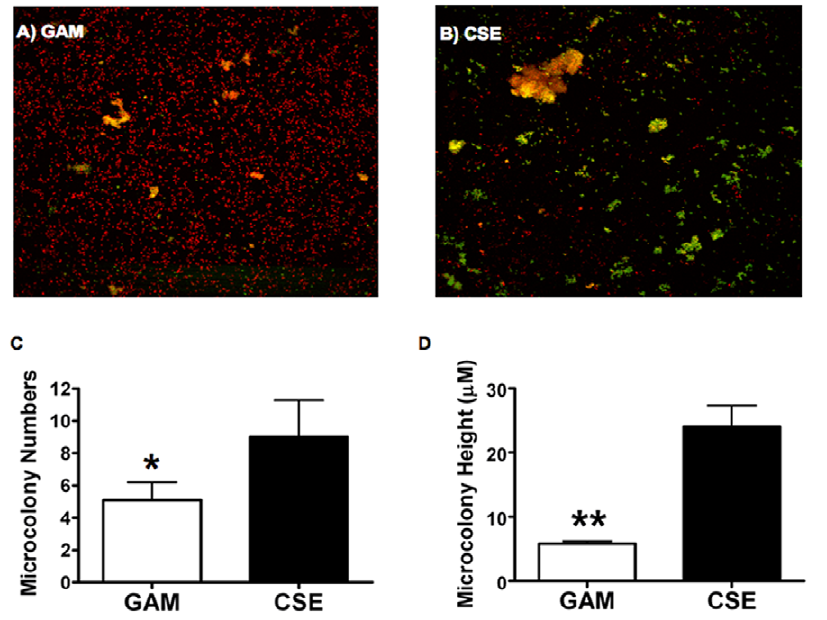
Figure 2. CSE exposure augments P.gingivalis - S.gordonii biofilm formation. Total number and height of microcolonies (yellow) formed by Hexidium iodide labeled S. gordonii (red) and Alexa-488 labeled P. gingivalis (green) biofilms, formed in an open flow system were quantified by taking optical section along the x-y and z axis at 1 m m intervals with a confocal microscope. CSE-exposed P. gingivalis associated strongly with S. gordonii as reflected by increased number of microcolonies formed (B) compared to control P. gingivalis grown in GAM (A). Total numbers (C) and average microcolony height (D) were quantified from 6 randomly chosen microscopic fields per biofilm using the FluoView software. * p , 0.05; ** p ,